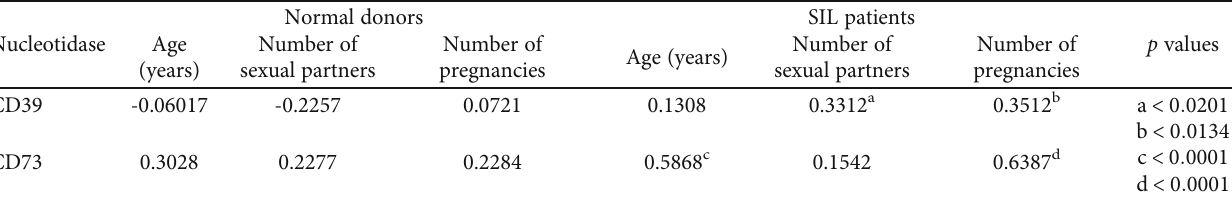
Values of Pearson ’ s coe ffi cient ( r ) are